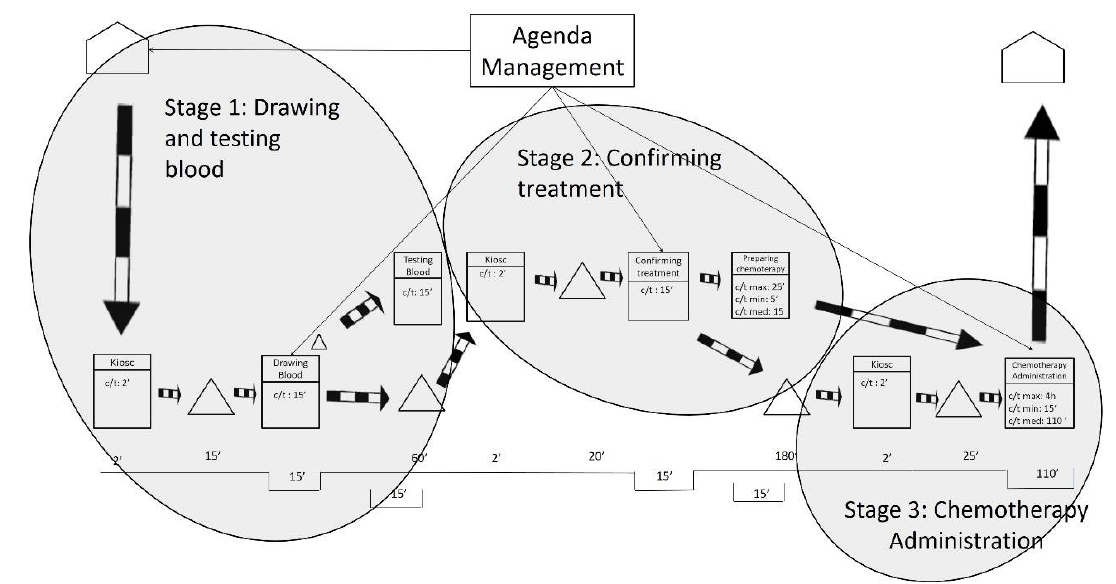
Figure 2. Stages in the current state map.